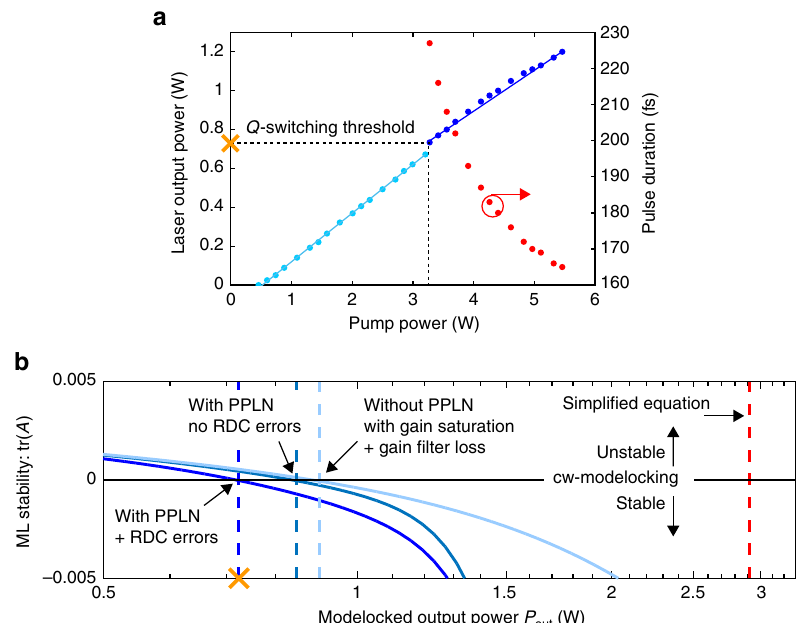
Fig. 4 Laser operation regimes. a Experimentally measured output power and pulse duration vs. diode pump power. The slope ef fi ciency amounts to 25% in the Q-switching region (light blue) and 21% in continuous wave (cw) modelocking (dark blue). b Q -switching threshold of the 10 GHz laser assuming a 2.8% output coupler: The modelocking stability is predicted via a matrix A (Methods), which describes the linearized dynamics of the laser gain and pulse energy around the steady state. For cw modelocking, trace( A ) < 0 is required 46 . The blue dashed lines represent crossing points where trace( A ) = 0 under the following assumptions. Right: taking fi rst only the effect of gain saturation and gain fi ltering into account; middle: adding the effect of a perfect QPM structure; left: assuming a realistic QPM structure with random duty cycle (RDC) errors in the ferroelectric domains arising during fabrication 48 . Including these RDC errors, we obtain a predicted Q -switching threshold output power of 724 mW which is remarkably close to the experimentally observed value of 734 mW. For comparison, the red dashed line shows the value predicted by a widely used analytical model